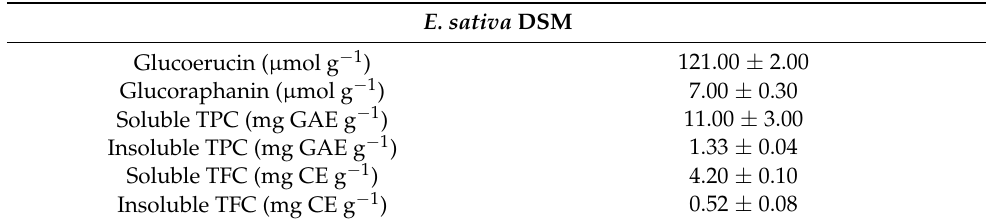
Table 1. Chemical characterization of E. sativa DSM. Glucosinolates content is expressed in µ mol g − 1 , total phenolic content (TPC) in mg gallic acid equivalent (GAE) g − 1 of DSM, while total flavonoids content (TFC) in mg catechin equivalent (CE) g − 1 of DSM. Mean values standard deviation ( n = 3) are